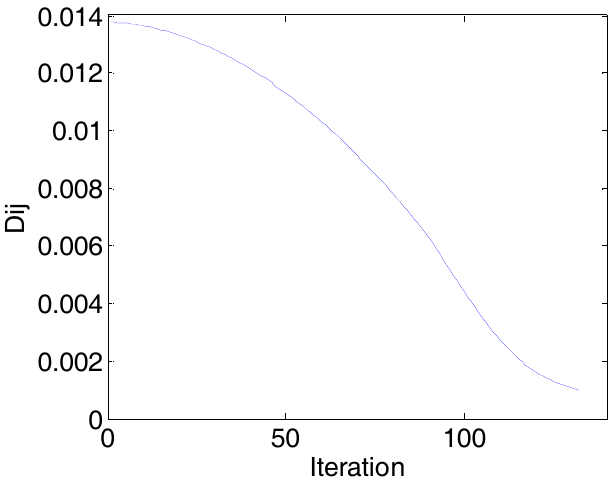
Figure 9. The convergence diagram of the PN algorithm (corn data) in the first round: Iterations vs. D ij ( D ij is the rate of change of the network continuity). When the iteration is 132, all the D ij are smaller than the threshold of stop, and the network is converged.